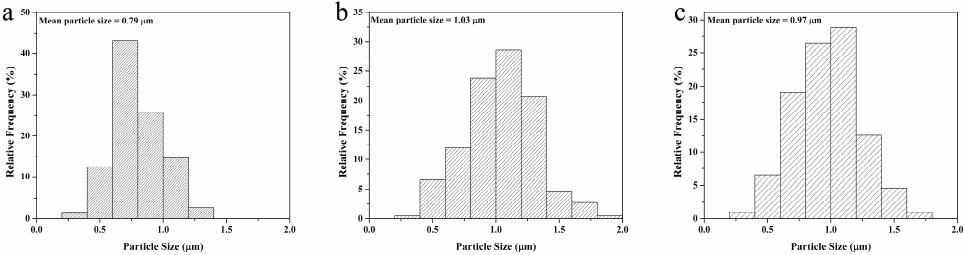
Figure 1. SEM images of the NH 2 -Fe-MIL-101 ( a , b ), Dini@NH 2 -Fe-MIL-101 ( c , d ) and PDA@Dini@NH 2 - Fe-MIL-101. Scale length: ( a , c , e ) 2 μm; ( b , d , f ) 500 nm.